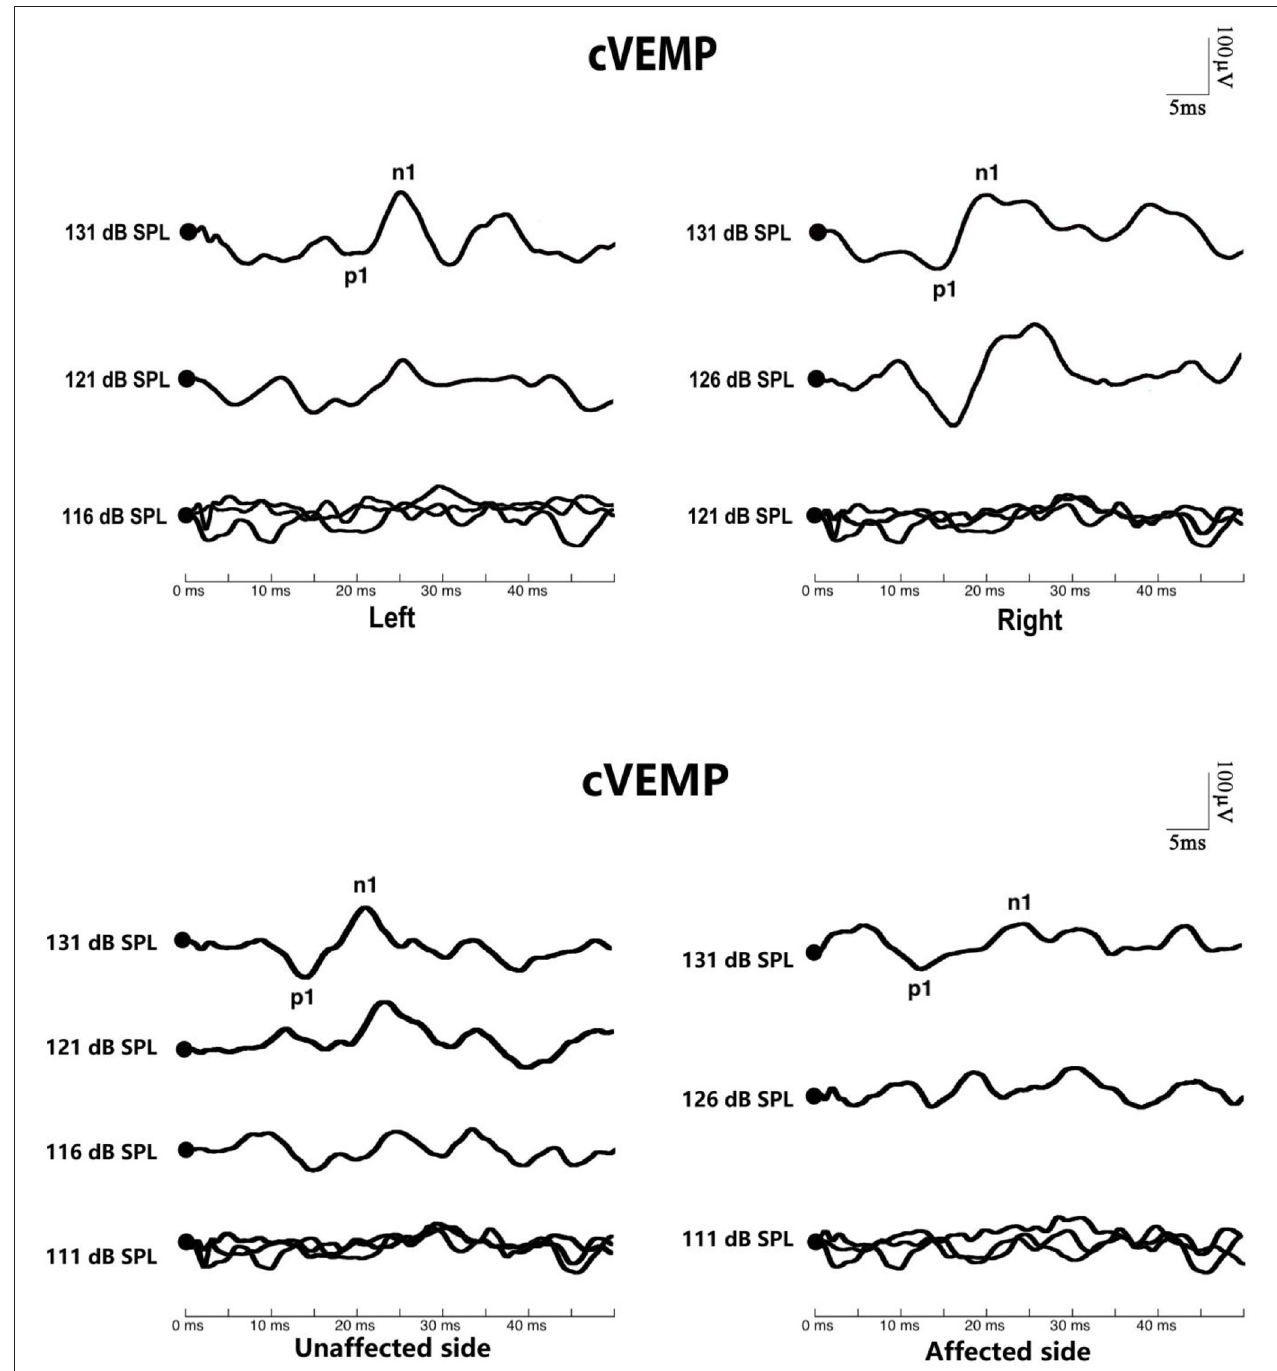
FIGURE 2 | Cervical vestibular-evoked myogenic potential (cVEMP) waves of patients with benign paroxysmal positional vertigo (BPPV). The top picture shows the cVEMP response of a normal subject. The bottom picture shows the cVEMP response of a patient with BPPV.